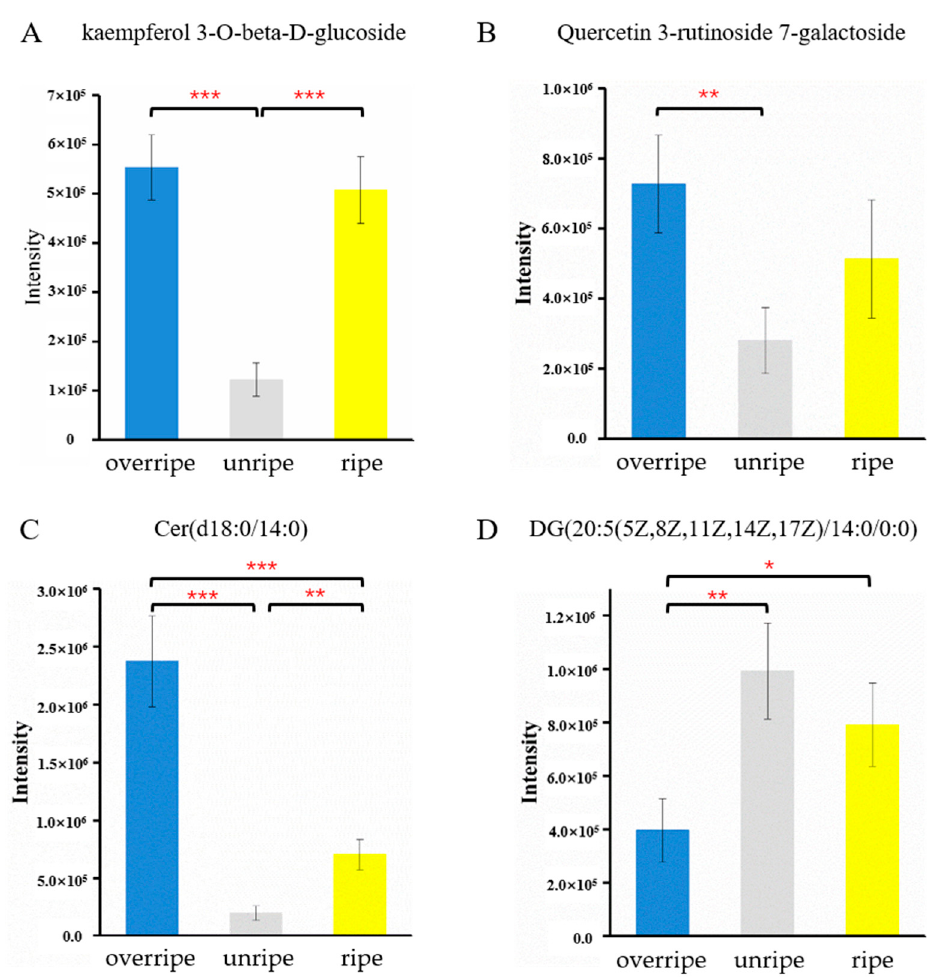
Figure 12. The differential phenols and lipids between different maturity grades. ( A ) Kaempferol 3 ‐ rutinoside ‐ 4 ′‐ glucoside; ( B ) Quercetin 3 ‐ rutinoside 7 ‐ galactoside; ( C ) Cer(d18:0/14:0); ( D ) DG(20:5(5Z,8Z,11Z,14Z)/14:0/0:0), in the methanol extracts of the flue ‐ cured NTL leaves. All data represent the mean values ± standard error. The asterisks represent significant differences. One asterisk 0.05 ≥ p > 0.01, two asterisks 0.01 ≥ p > 0.001, three asterisks p ≤